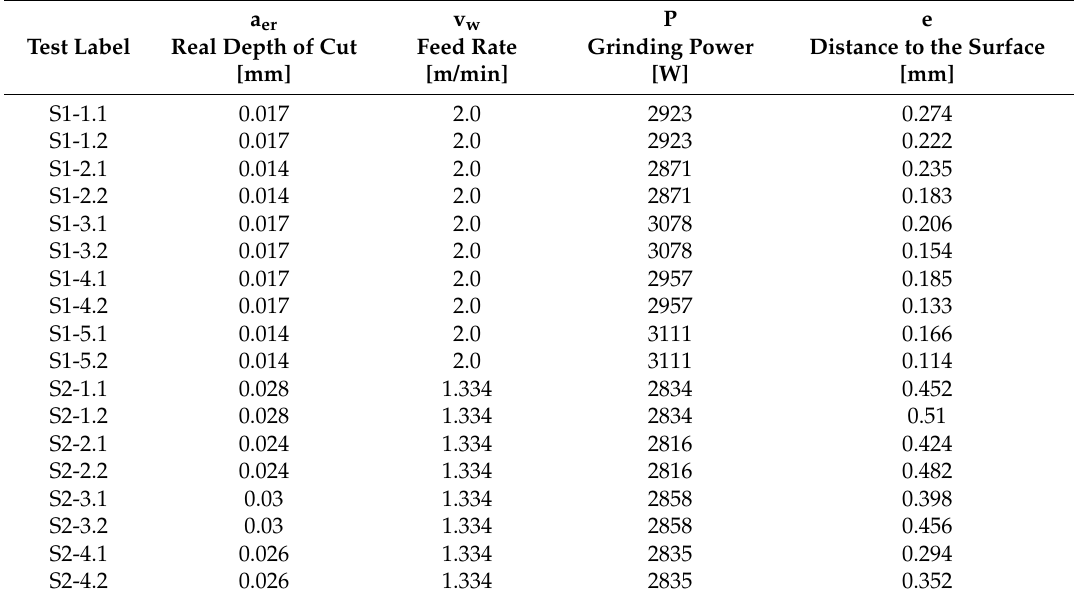
Table 2. Real values of the grinding parameters measured on the